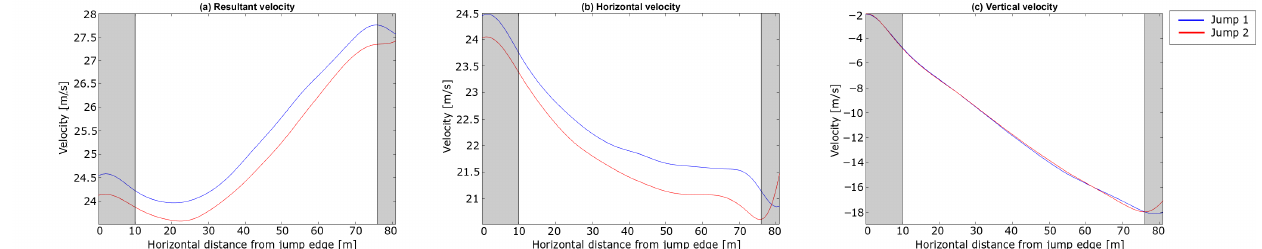
Figure 14. Velocity components in the flight phase for the jumps in the case study. The gray shaded areas highlight the take-off and landing phases: ( a ) shows the resultant velocity v , ( b ) the horizontal velocity v x and ( c ) the vertical velocity v y . The horizontal length from the in-run edge is shown on the x-axis and velocity is shown on the y-axis.